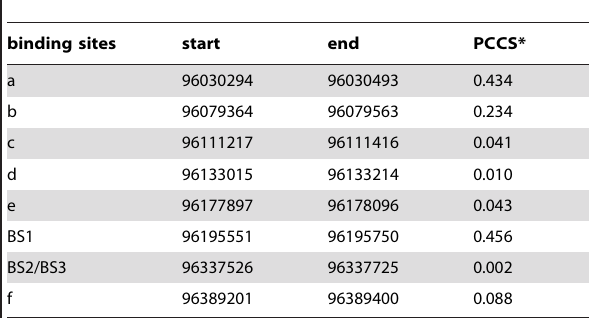
Table 3. PhastCons Conservation Scores (PCCS) of the identified p63 binding sites that potentially function as enhancer elements.